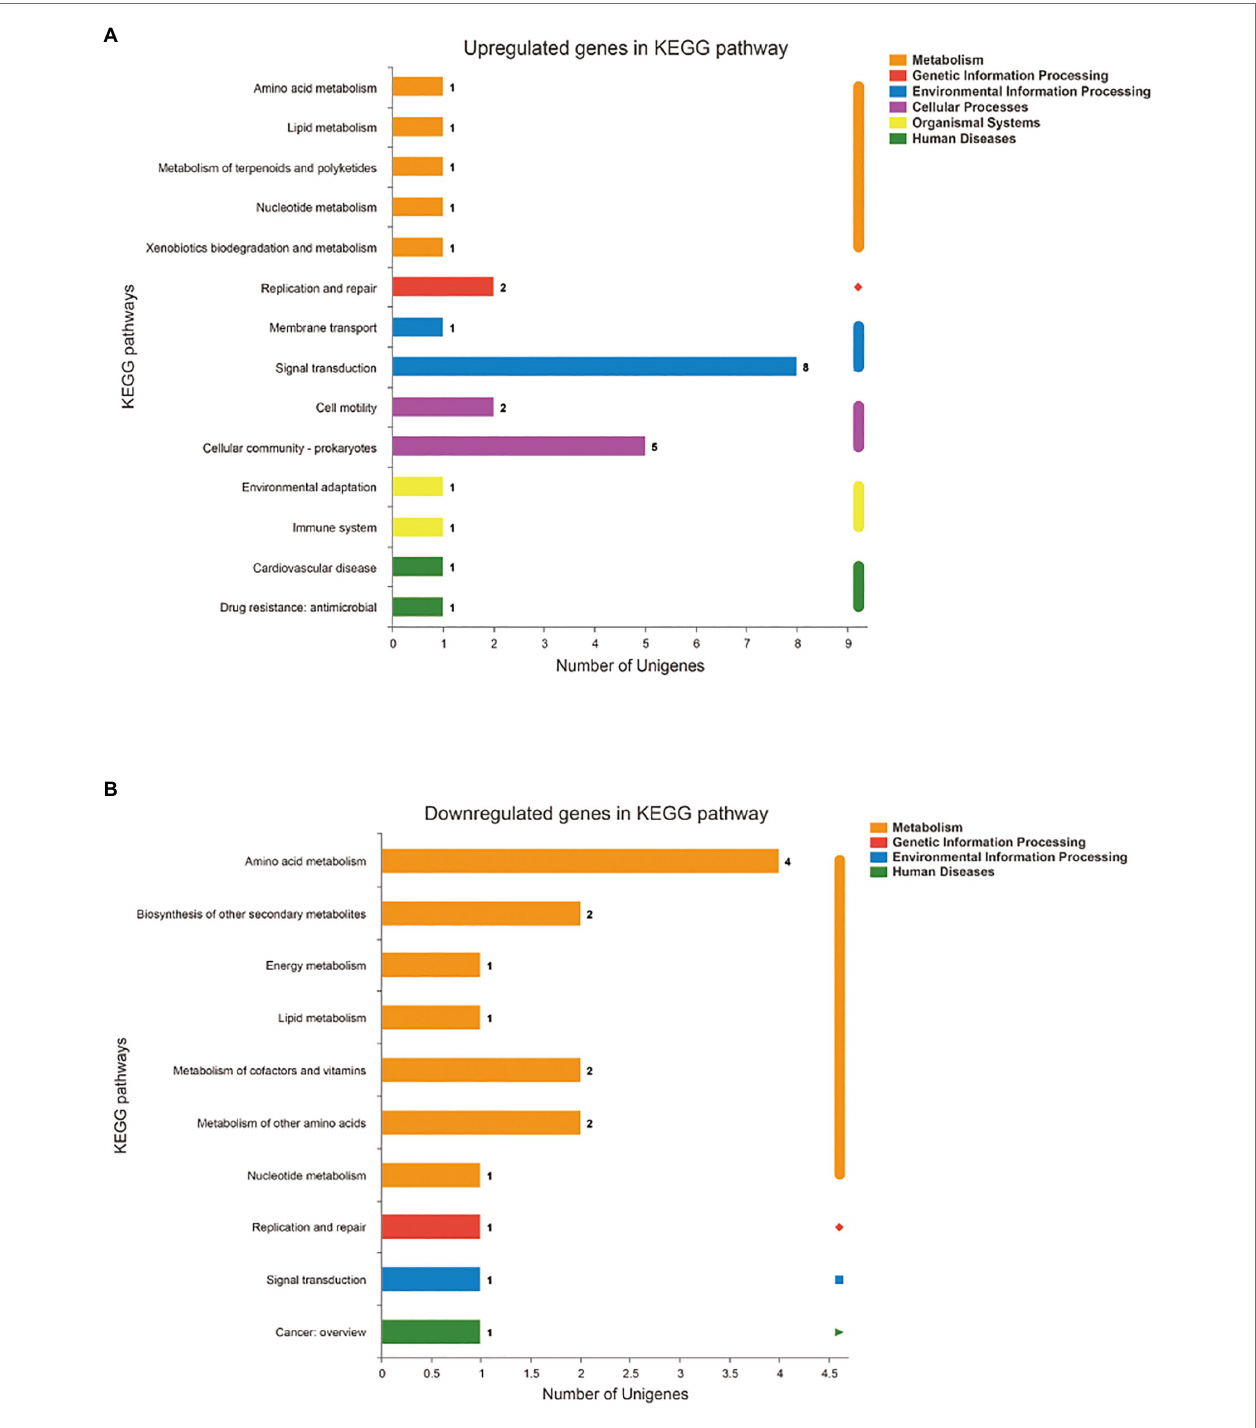
FIGURE 9 | Functional annotation and enrichment of genes of SMS. (A) Kyoto Encyclopedia of Genes and Genomes (KEGG) pathway of upregulated genes in SMS. (B) KEGG pathway of downregulated genes in SMS. The X-axis of (A) and (B) is the number of genes annotated to the KEGG pathway, the Y-axis of (A) and (B) is the name KEGG metabolic